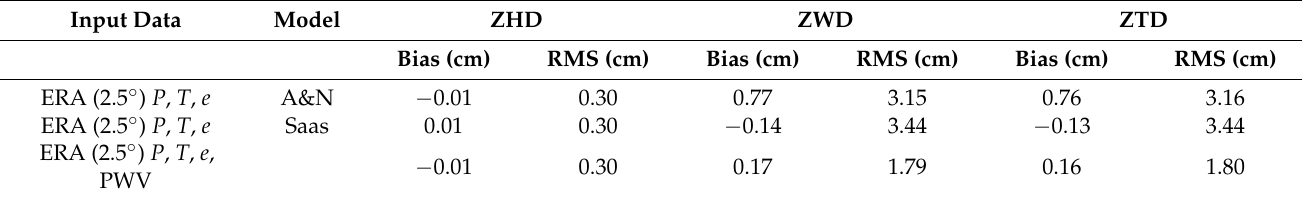
Table 5. Statistics of global mean accuracies of ZHDs, ZWDs, and ZTDs calculated from ERA-Interim surface forecast data, with the reference values from IGRA data over 530 stations during